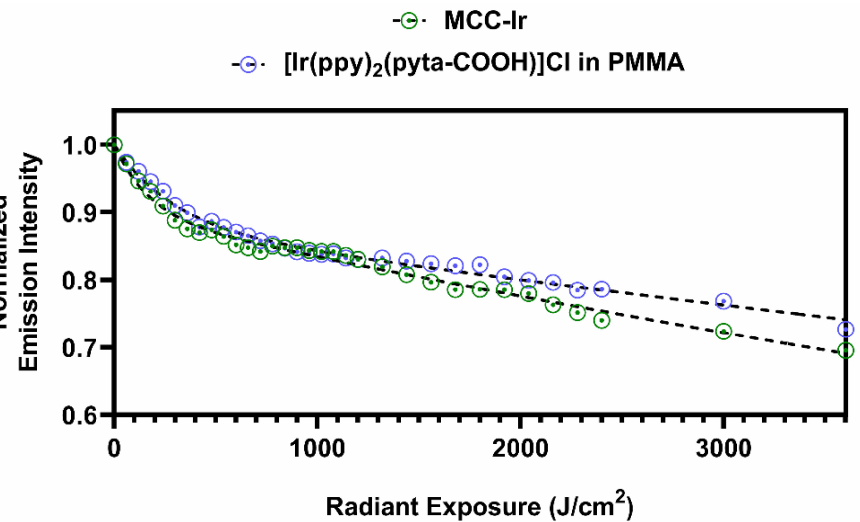
Figure 4. Photostability under UV irradiation of MCC-Ir compared to [Ir(ppy) 2 (pyta-COOH)]Cl. Emission spectra were recorded at different time points during the irradiation. The excitation wavelength was 310 nm, and the slits were set at 2 nm for both excitation and emission beams. The emission intensities at the highest peak ( λ = 508 nm) are plotted against the corresponding radiant exposure and fit with double exponential decay functions (dashed line) according to Equation